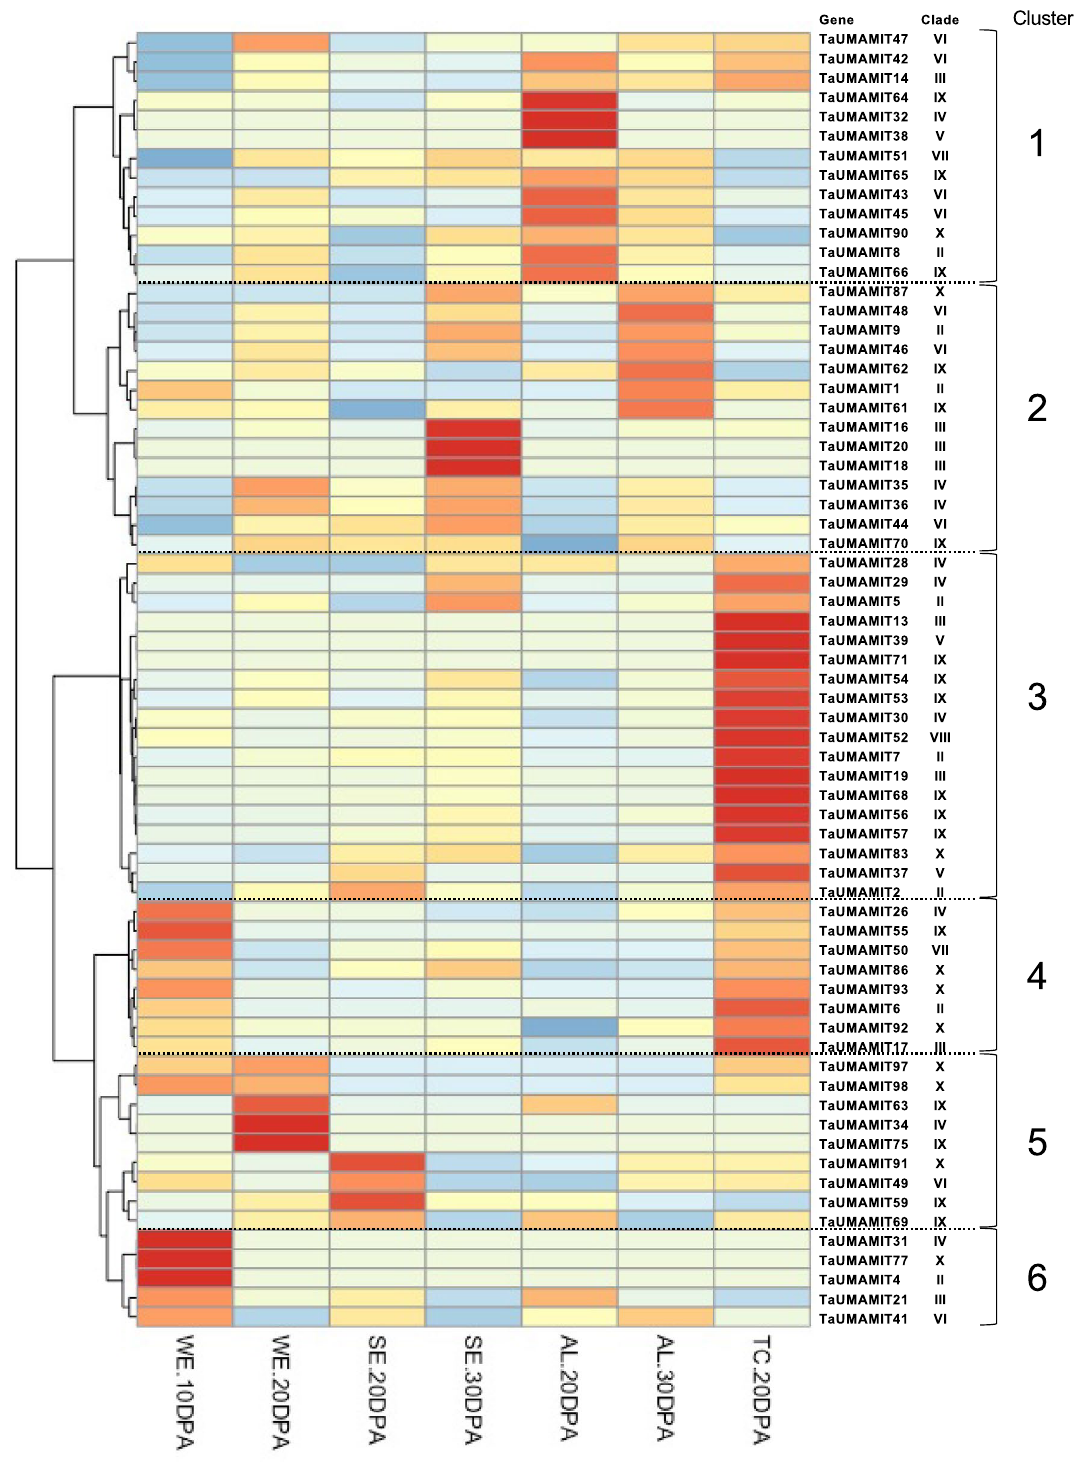
Figure 4. Expression of UMAMIT genes in different cell types of developing grains. The heatmap is scaled by row (each gene). For each gene, the expression values were averaged for all representing wheat subgenomes. WE Whole endosperm, WE Starchy endosperm, AL Aleurone layer, TC Transfer cells. UMAMIT genes without expression in any of the cell type has been excluded from the